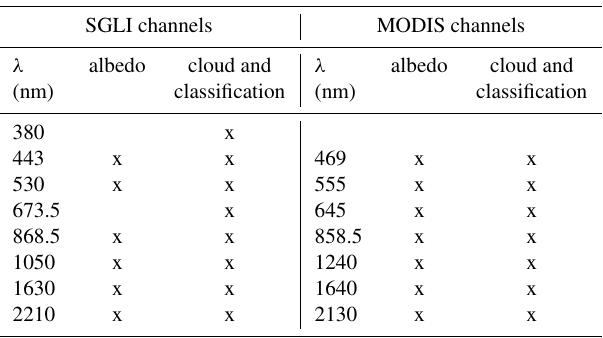
Table 3. Central wavelengths used by SGLI and MODIS to re- trieve albedo and obtain cloud and surface classification mask. The 673.5nm wavelength channel from SGLI was proven to be saturated and hence was not used to derive